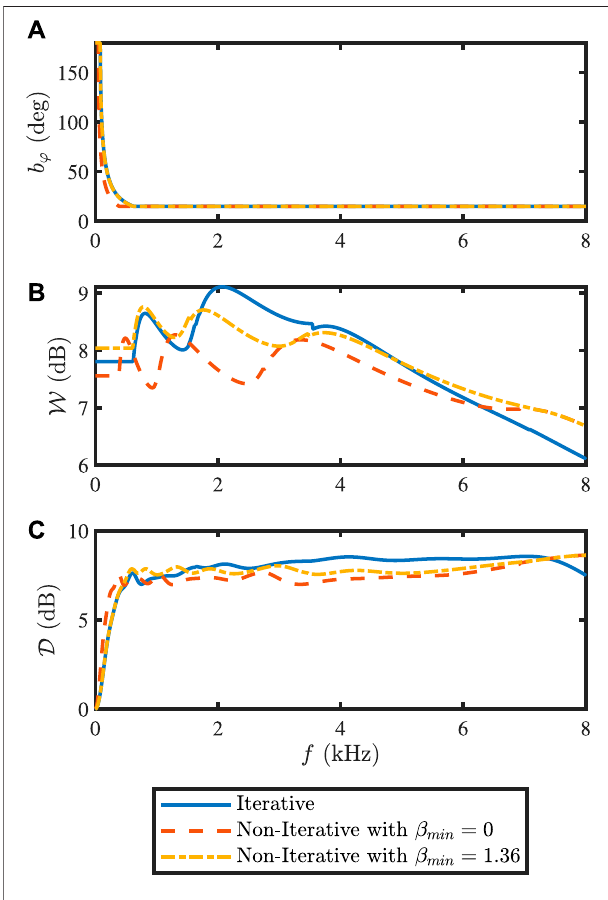
FIGURE 7 | (A) Beamwidth, (B) WNG, and (C) narrowband directivity factor asafunctionoffrequency:iterative(solidline), non-iterative with β min =0 (dashed line), and non-iterative with β min = 1.36 (dash-dot line). The obtained W [ 0 , 8 kHz ] are respectively 7.8, 7.5, and 7.8 dB. The obtained D I [ 0 , 8 kHz ] are respectively 7.6, 7.3, and 7.4